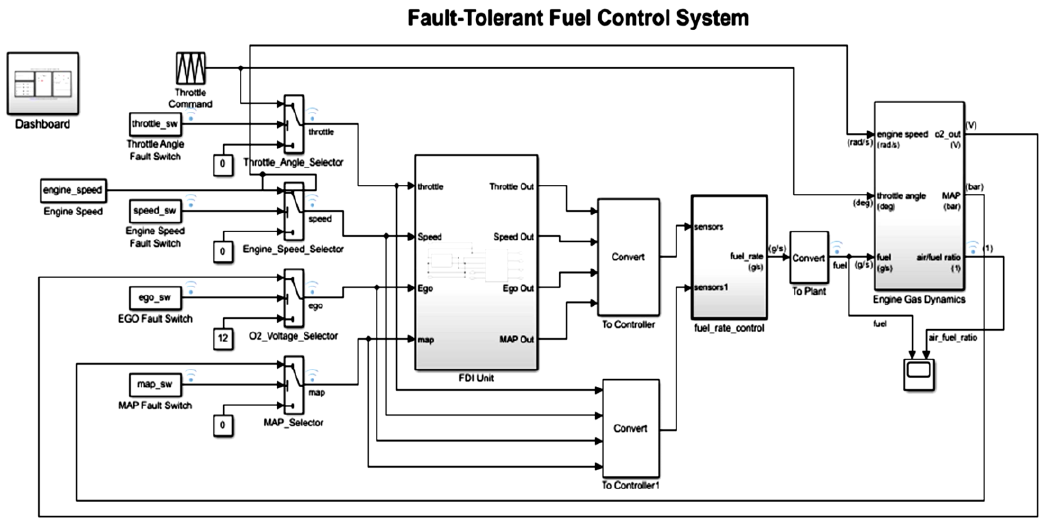
Figure 8. Matlab diagram of proposed AFTCS.